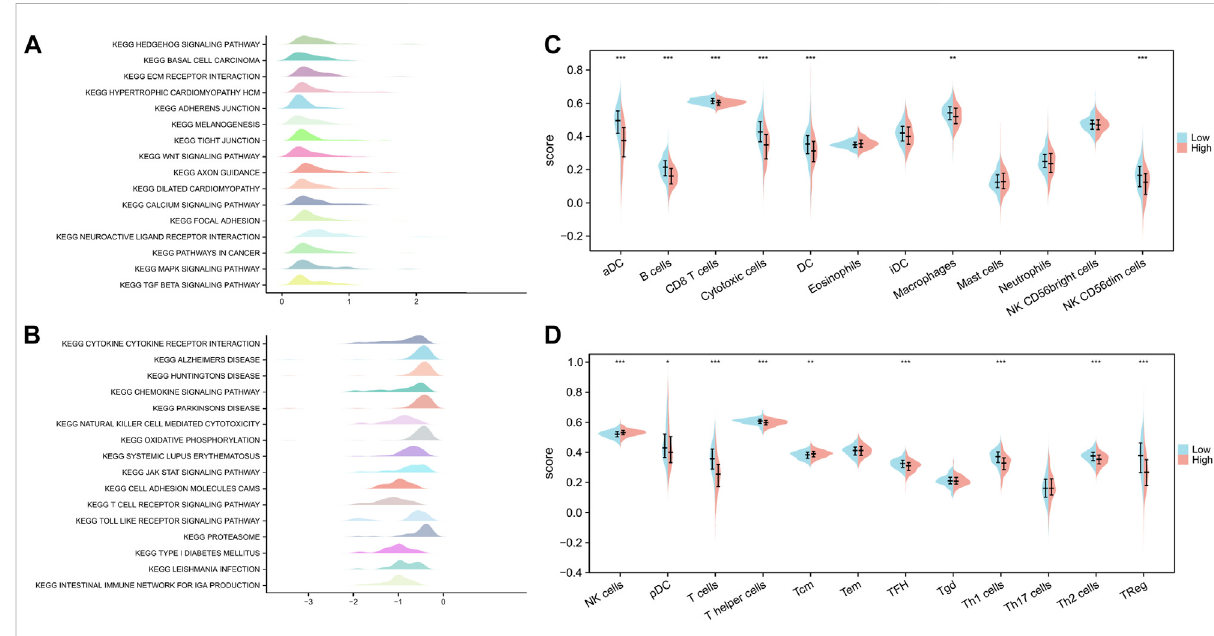
FIGURE 9 FunctionalenrichmentanalysisofICD-relatedprognosticsignatureandinteractionwithimmunecellin fi ltration. (A,B) GSEArevealedbiological differences between high- and low-risk subgroups. (C,D) Differences in the scores of 24 immune-in fi ltrating cells between high-risk and low-risk subgroups. p values are p ≤ 0.5 (*), p ≤ 0.01 (**), p ≤ 0.001